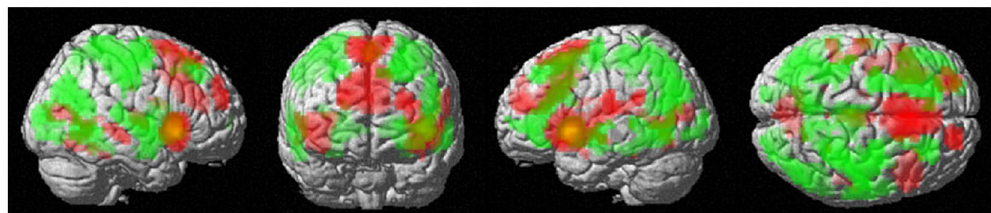
hormone levels (all | b | < 0.20, all SE b < 0.15, all | t | < 1.50, all p > 0.05). Neuroimaging results. Overall activation inhibited vs. non inhibited Stop trials . Compared to the non-inhibited Stop trials, the inhibited Stop trials strongly activated a large fronto-temporal and subcortical net- work including bilateral basal ganglia (BG) and hippocampus. Peaks of activation above threshold were located in the bilateral putamen and superior frontal gyri, left inferior frontal gyrus, right poscentral and left paracentral gyri, left parahippocampal area and bilateral temporal and occipital areas (Fig. 2, in green.) Compared to the inhibited Stop trials, the non-inhibited Stop trials strongly activated a temporo-medial net- work including anterior cingulate cortex (ACC), bilateral insula, right middle temporal gyrus and subcortical structures (Fig. 2, in red.) Region of interest (ROI) analysis: bilateral putamen. For both left and right putamen we found a signifi- cant decrease in the blood oxygen level dependent (BOLD)-response during the luteal phase compared to the pre-ovulatory phase ( b = − 0.47, SE b = 0.18, t (33) = − 2.69, p < 0.05 for the left and b = − 0.38, SE b = 0.18, t (33) = − 2.12, p < 0.05, for the right putamen; Fig. 3b). We did not observe any differences between pre-ovulatory phase and luteal phase vs. menses (all |b| < 0.32, all SE b < 0.20, all | t | < 1.70, all p > 0.05). The main effects of base- line IC and its interaction with cycle phase were no significant for either left or right putamen BOLD-response (all | b | < 0.10, all SE b < 0.20, all | t | < 0.50, all p > 0.05). None of the significant changes in activation across the menstrual cycle were related to hormone levels (all | b | < 0.05, all SE b < 0.10, all | t | < 0.50, all p > 0. 05). The SSRT could be predicted by the right putamen BOLD-response ( b = − 0.21, SE b = 0.09, t (71) = − 2.21, p < 0.05), but not